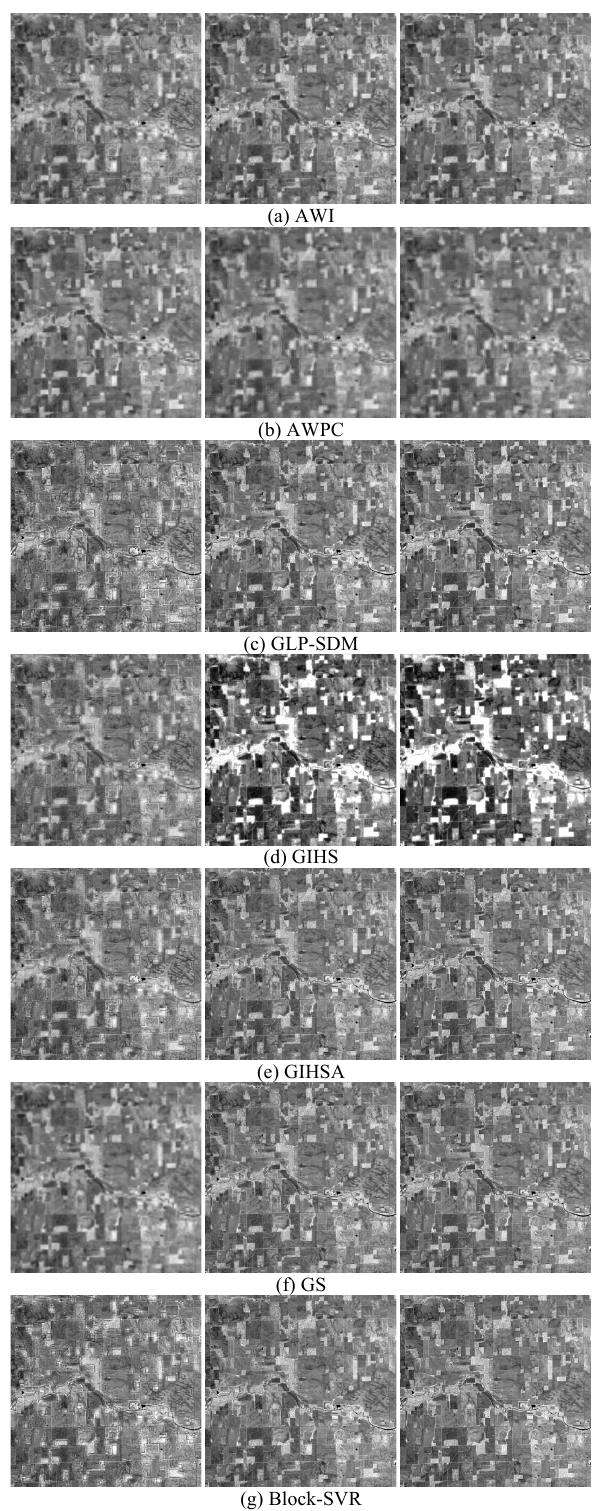
(g) Block-SVR Figure 3. Pansharpened band 4 in an agricultural area using 0% (left), 50% (center), and100 % (right) overlapping PAN images Pansharpened images of an urban area using 50% overlapped PAN images are shown in Figure 4, together with the original and spatially degraded NIR band (the brightness of the image is enhanced linearly to the same level because the original result was too dark to show). AWI and AWPC were less sharp, especially in the region of small buildings and narrow roads.